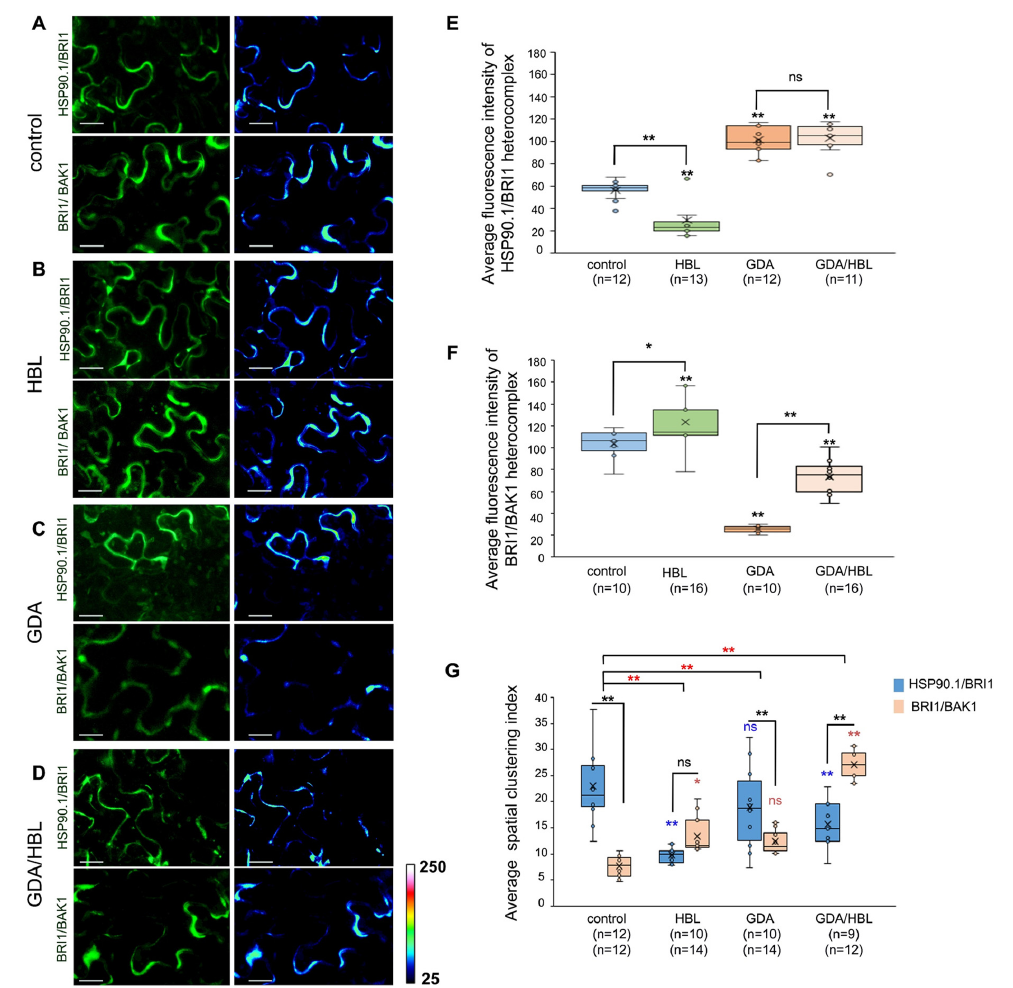
Figure 6. The association of HSP90.1 with the BRI1 receptor affects the activation of BRI1/BAK1 heterocomplex upon HBL perception. ( A – D ) BiFC interaction assays in tobacco leaf epidermis of HSP90.1 with BRI1 and BRI1 with BAK1 under control conditions and after treatments with 1 μ M HBL for 4 h or upon treatment with 10 μ M GDA for 12 h followed by application of 1 μΜ of HBL for 4 h. From left to right: fluorescent YFP signals, and semi-quantitative fluorescence intensity evaluation of HSP90.1/BRI1 or BRI1/BAK1 levels using pseudo-color-coded range from the scale, where dark blue represents zero intensity (25 in arbitrary units) and white represents maximum intensity (250 in arbitrary units). ( E ) Quantification of the average fluorescence intensity of HSP90.1/BRI1, heterocomplex at the PM under the indicated conditions. Three different areas of low and high fluorescence intensity were measured per cell . ( F ) Quantification of the average fluorescence intensity of BRI1/BAK1 heterocomplex at the PM under the indicated conditions. ( G ) Quantification of the relative spatial distribution of HSP90.1/BRI1and BRI1/BABK1 complexes at the PM under the indicated conditions. n, the number of cells analyzed in each treatment. Box plots show the first and third quartiles, split by the median (line) and mean (cross). Data are analyzed by one-way ANOVA followed by Holm’s test; * p < 0.05, ** p < 0.01, ns—non-significant. The red stars in the diagram show the statistically significant differences between the treatments analyzed by two-way ANOVA. Scale bars, 25 μ m.